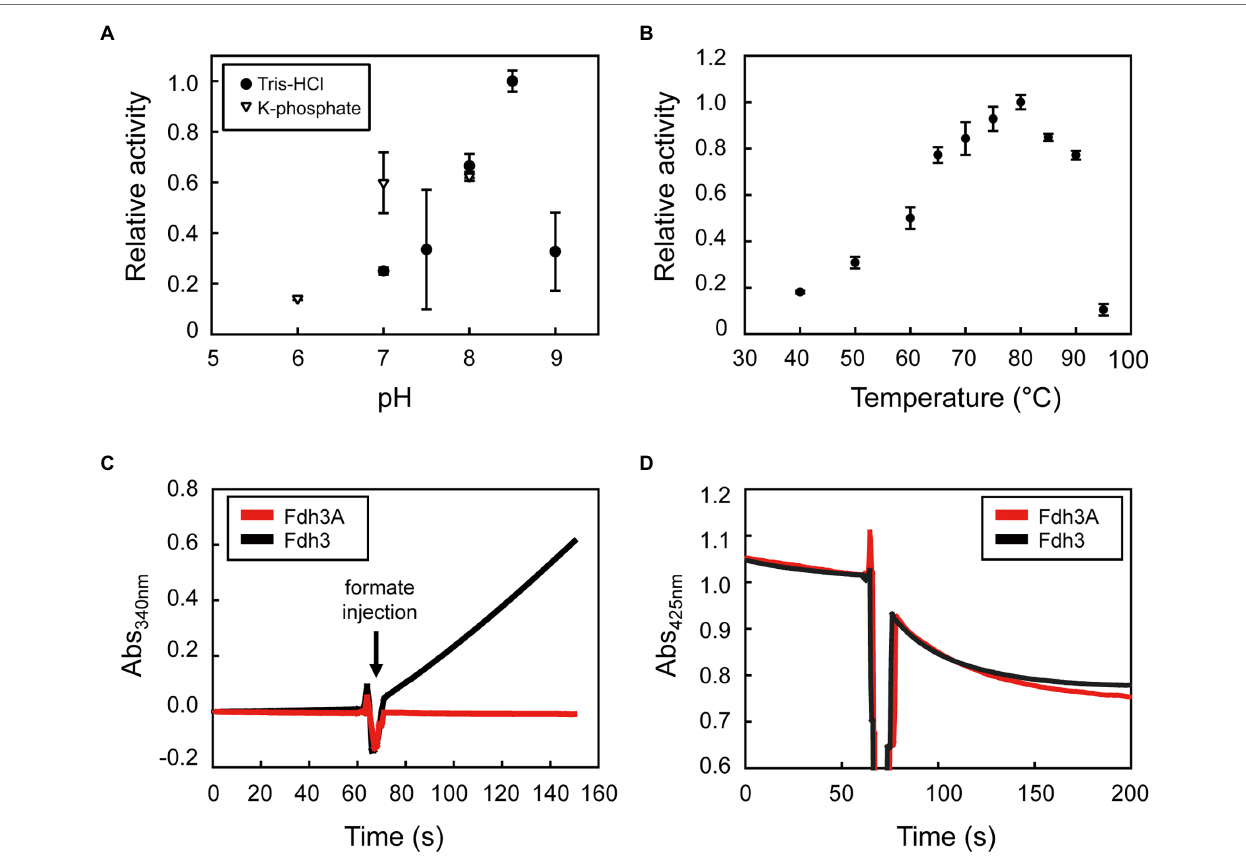
FIGURE 4 | Biochemical properties of Fdh3. (A) The pH dependence of Fdh3 determined by formate-dependent NADP + -reducing activity in the pH 6.0–9.0 range in 100 mM potassium phosphate buffer (triangle) or 100 mM Tris–HCl (circle). (B) The temperature dependence of Fdh3 determined in the 40–95 ° C range in 100 mM Tris–HCl (pH 8.5) by measuring formate-dependent NADP + -reducing activity. (C) Comparison of formate-dependent NADP + -reducing activity between Fdh3 and Fdh3A. (D) Comparison of formate-dependent ferredoxin-reducing activity between Fdh3 and